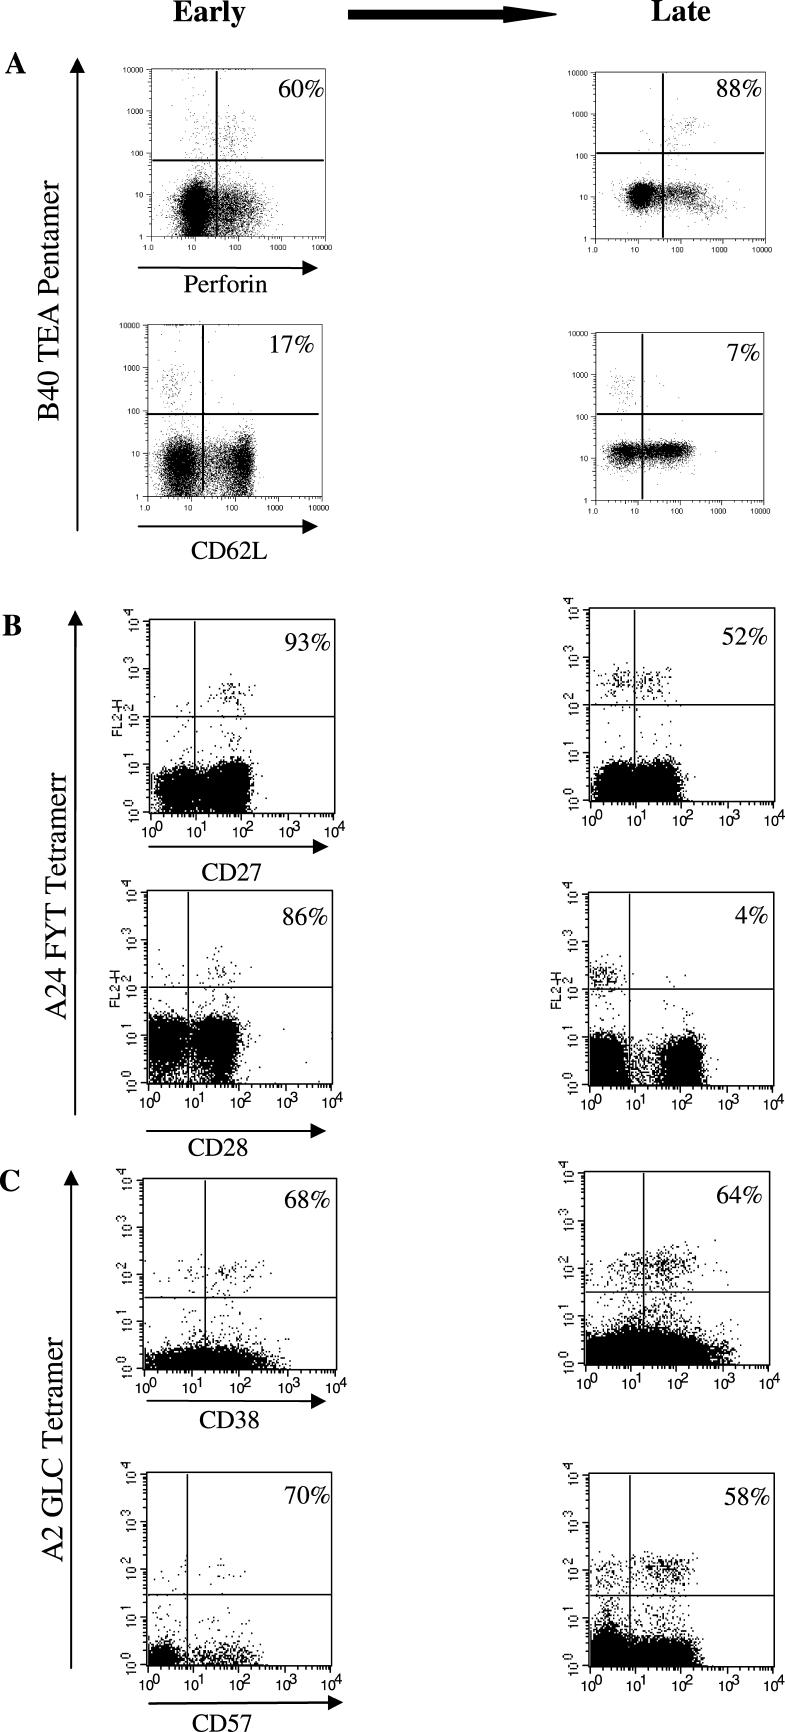
Representative Ex Vivo Phenotyping of B19-Specific CD8+ T Cell Populations over TimePercentages shown are the frequency of marker-positive cells amongst multimer-positive cells (plots gated on live CD8+ lymphocytes ex vivo).(A) Patient S2 B40 TEA pentamer staining at 4 mo (left) and 21 mo (right), showing perforin and CD62L levels.(B) Patient O3 A24 FYT tetramer staining at 2 mo (left) and 20 mo (right), showing CD27 and CD28 staining.(C) Patient O5 A2 GLC tetramer staining at 4 mo (left) and 18 mo (right), showing CD38 and CD57 staining.